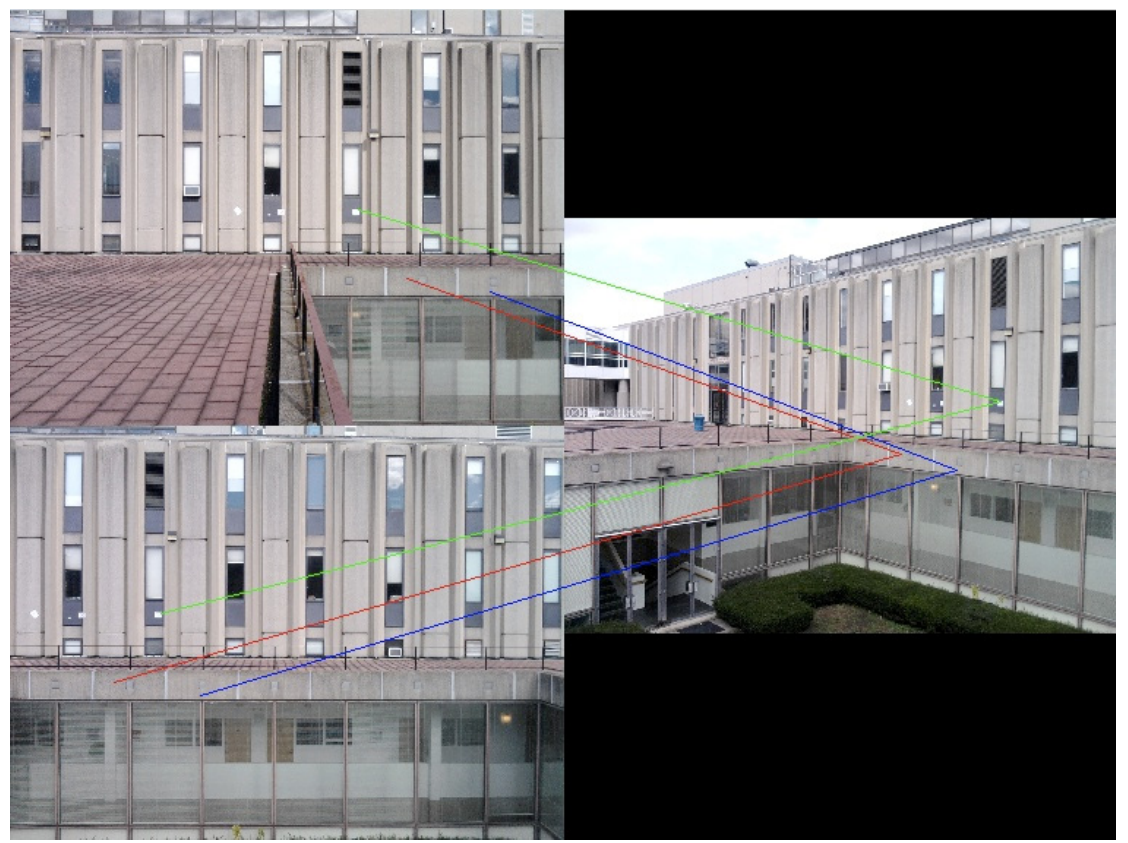
Figure 13. Location with respect to campus